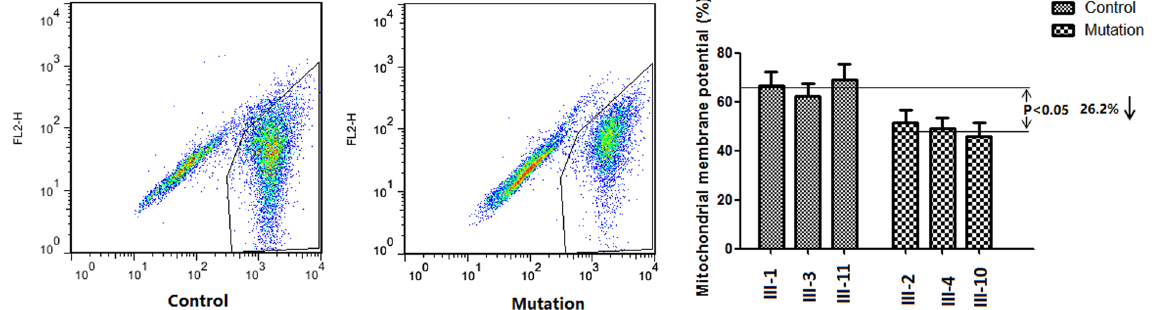
Figure 4. Mitochondrial membrane potential depolarization ( ΔΨ m ). The ΔΨ m was measured in three mutant and three non-mutant cell lines, and a statistically significant decrease was observed. The results showed that the mean ΔΨ m in mutant cell lines decreased 26.2% compared with the control cell lines ( P <